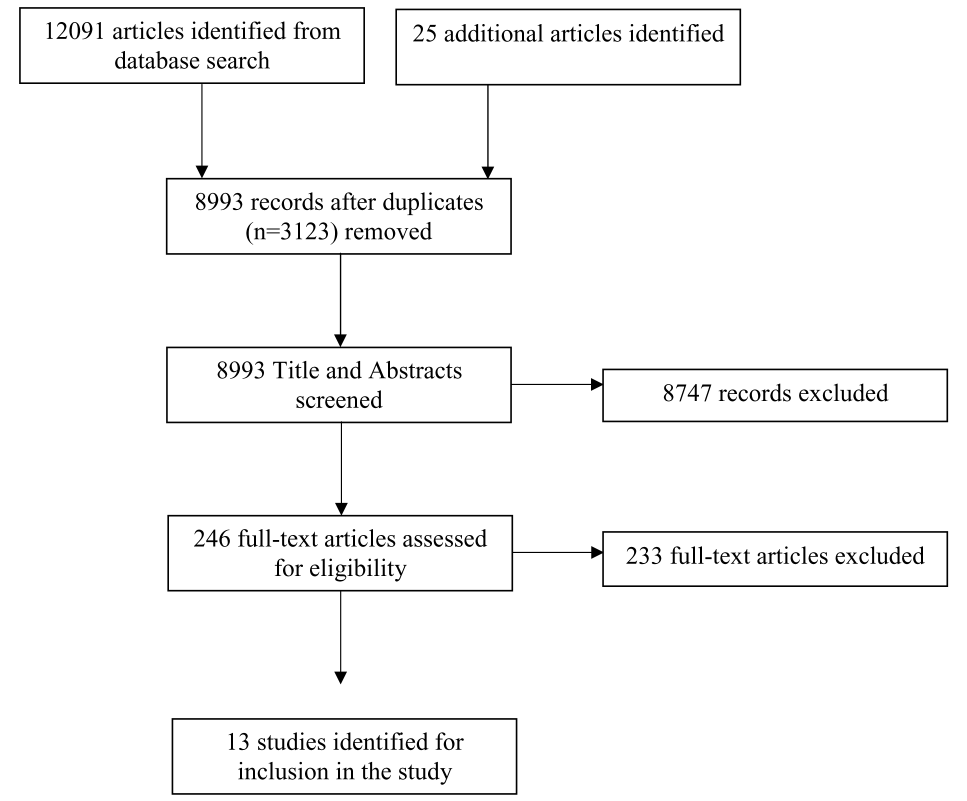
Figure 1. PRISMA flow